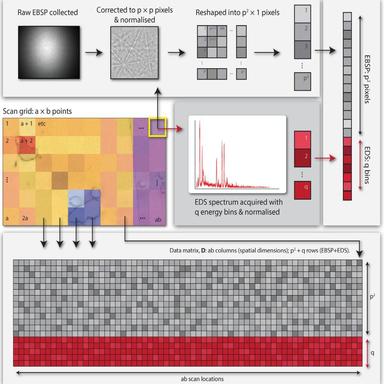
The work flow for construction of the data matrix, D, used for the weighted PCA method.